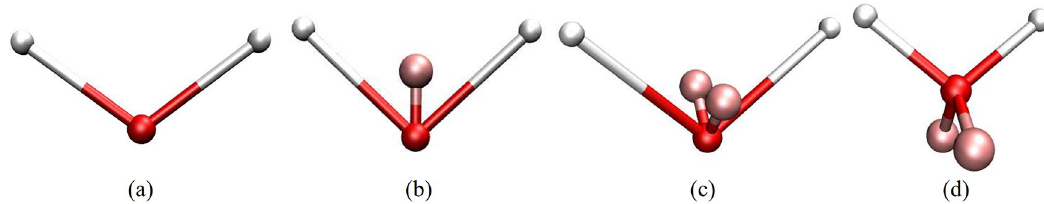
Fig 1. Rigid n-point water model geometries for n = 3, n = 4 and n = 5. Hydrogen, Oxygen and the extra interaction point with a point charge but no mass are represented as white, red and pink spheres respectively. 4, and 5-point water models have zero charge on their oxygen, the negative charge is placed on the extra point(s). (a) 3-point water model. (b) 4-point water model. (c) and (d) Different possible non-planar configurations of 5-point water models [18].